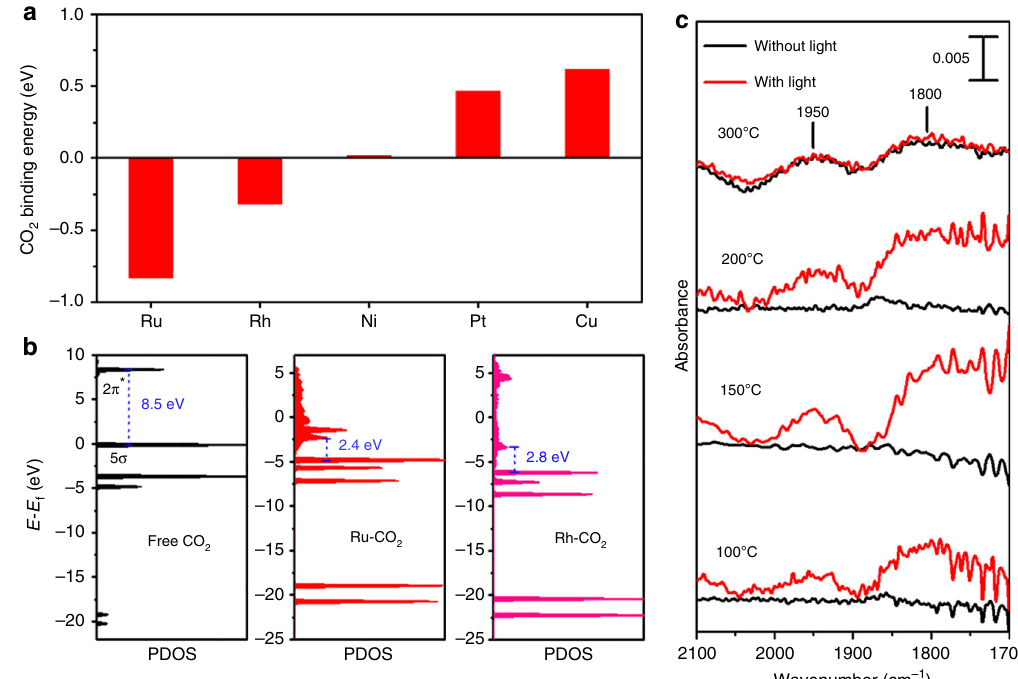
Fig. 3 Binding of CO 2 on metal surfaces. a CO 2 binding energy and b HOMO-LUMO gap of free CO 2 , adsorbed CO 2 on the Ru surface, or adsorbed CO 2 on the Rh surface, obtained using DFT calculations. c DRIFT spectra for CO 2 adsorption on Ru/SiO 2 with or without light irradiation. 50 sccm of 0.5% CO 2 /N 2 was fl owed for 10 min; the cell was purged with 60 sccm of N 2 for 15 min to desorb the weakly adsorbed CO 2 , and the IR spectra were